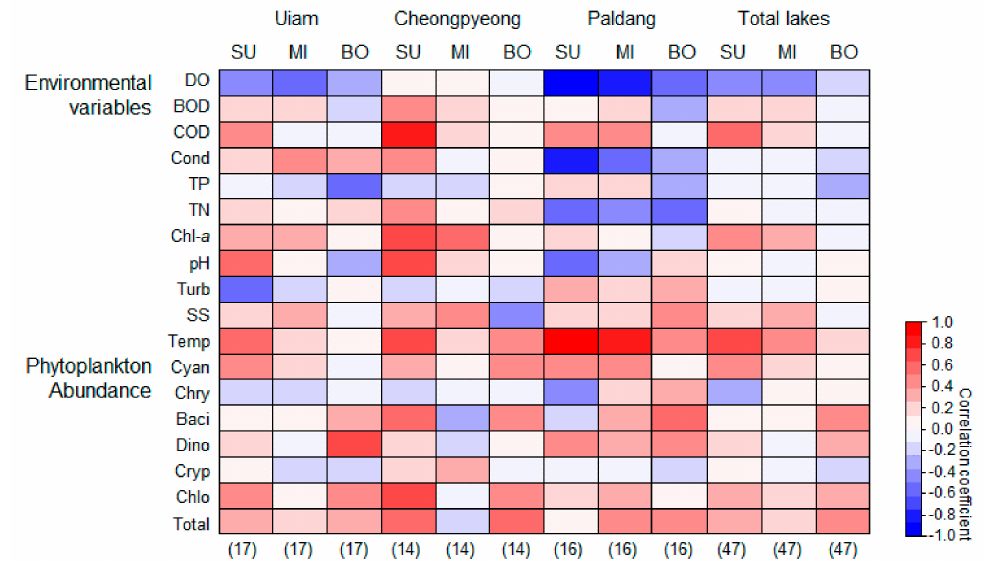
Figure 5. Correlation between geosmin and phytoplankton abundance and environmental variables. The color gradient (from − 1 to 1) indicates Spearman’s correlation coefficients. The darker red indi- cates a higher positive correlation ( p < 0.05), and darker blue indicates a higher negative correlation ( p < 0.05). The numbers in parenthesis indicate the number of sampling sizes. Abbreviation of each variable indicated in Table 2. SU: surface layer, MI: middle layer, BO: bottom layer, and Total lake: pooled sample in each layer from three